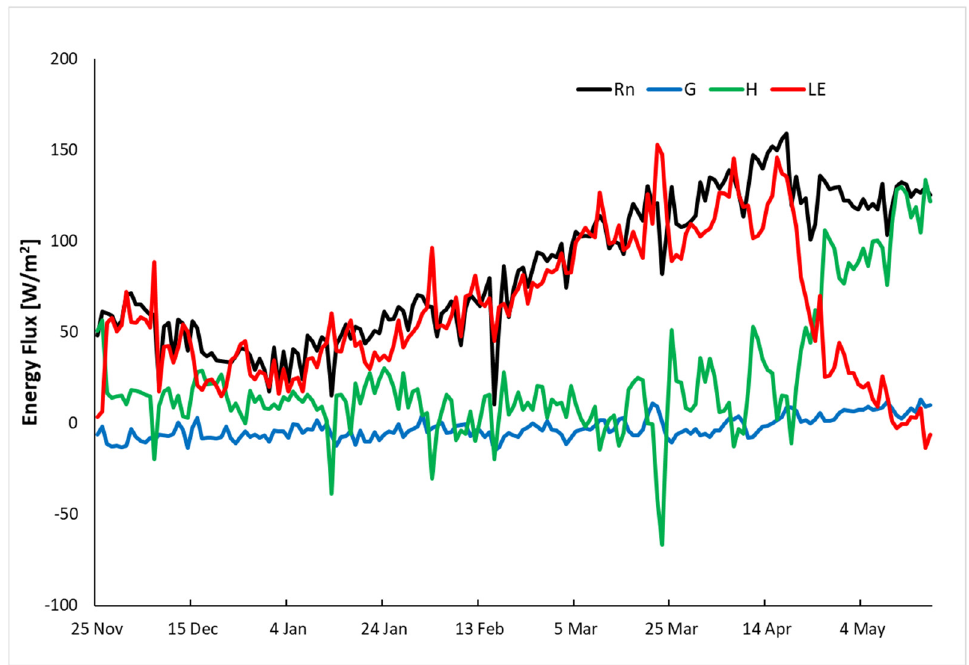
Figure 7. Components of the Surface Energy Fluxes (H—Sensible Heat Flux, LE—Latent Heat Flux, G—Ground Heat Flux, and Net Radiation Flux) at Sids Site Egypt for the winter wheat crop.